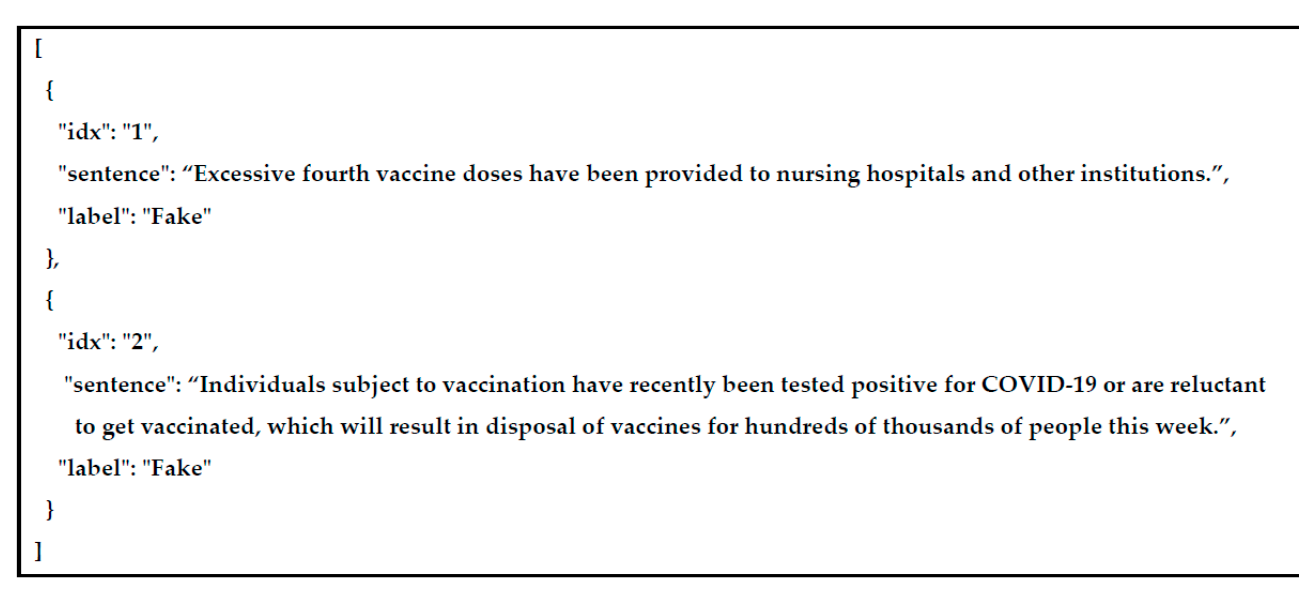
Figure 2. A part of extracted datasets in a JSON format.